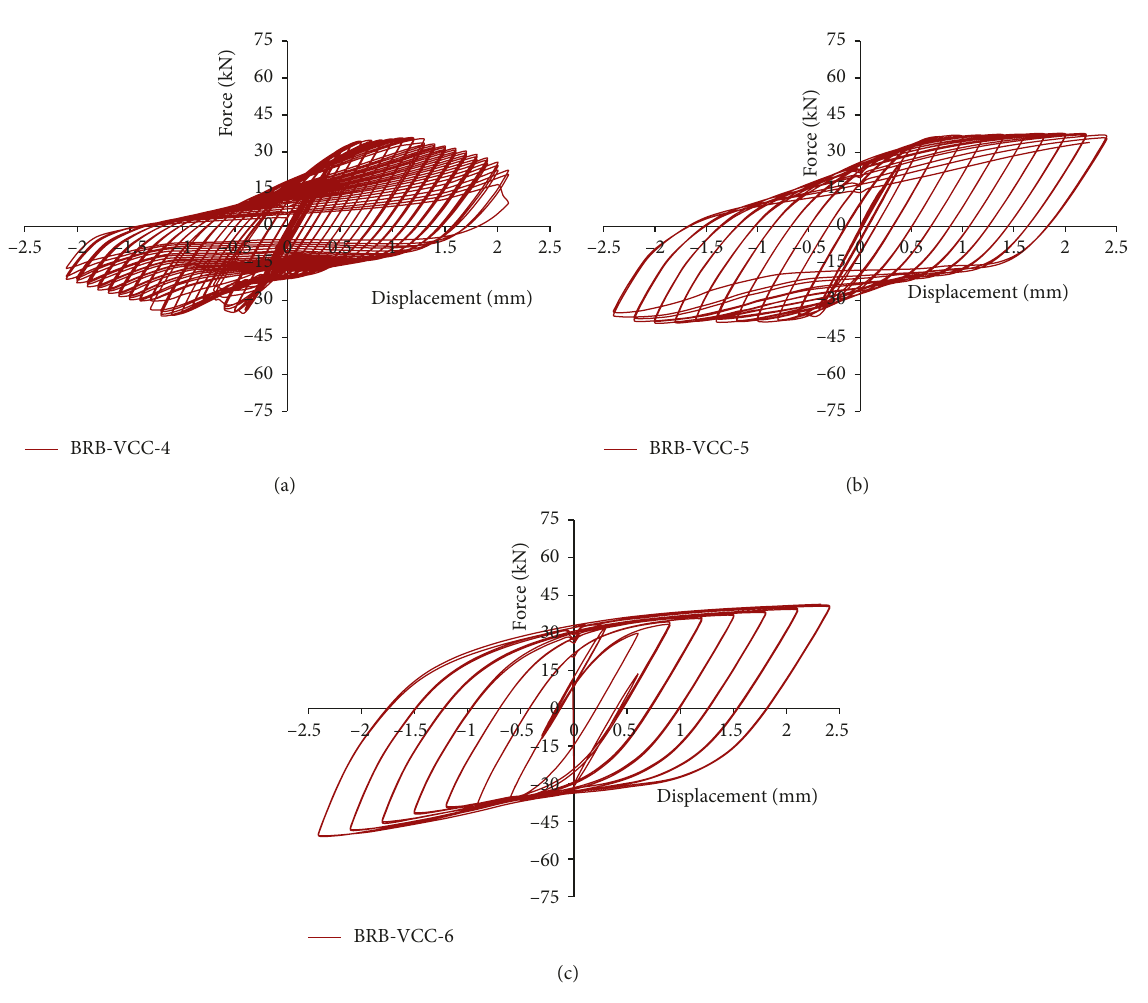
Figure 11: Hysteresis loops of S-II. (a) BRB-VCC-4. (b) BRB-VCC-5. (c)